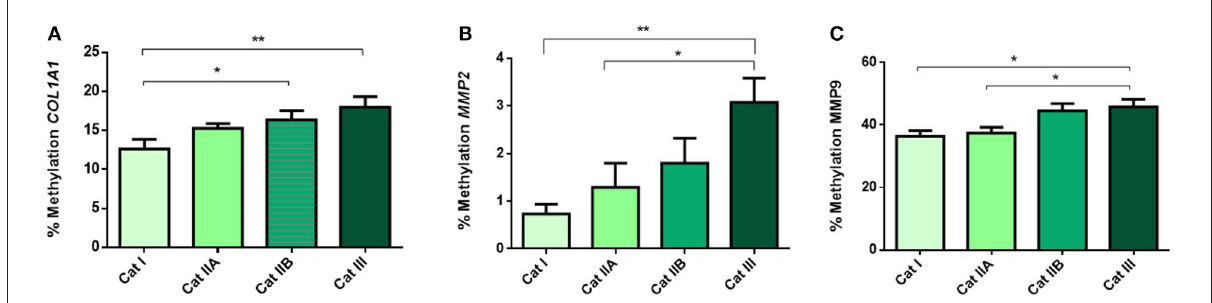
FIGURE5 Correlation between methylation and transcription of (A) MMP2 and (B) MMP9 in equine endometrial categories graded as Kenney and Doig’s classification.